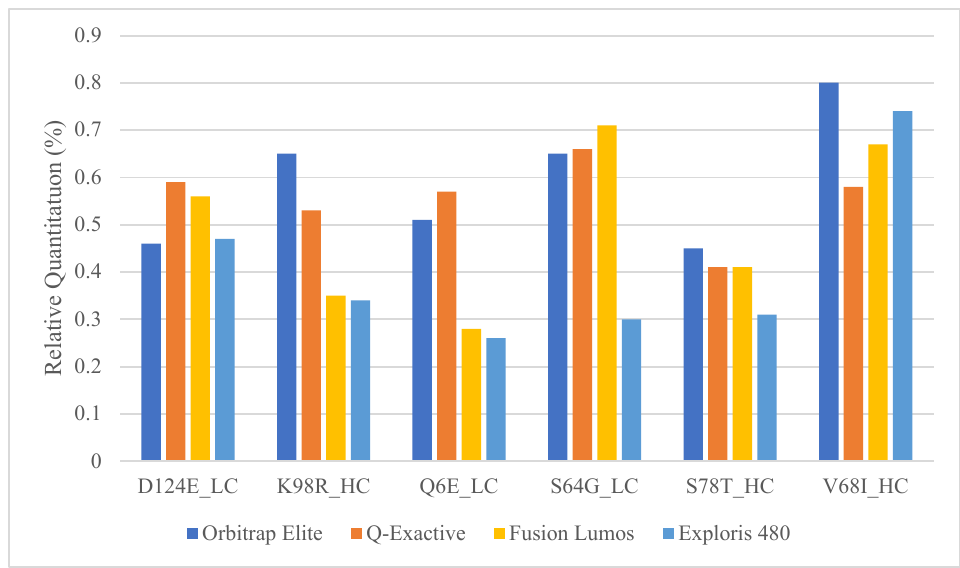
Figure 3. Relative quantitation of the mAb1 and mAb2 peptide pairs in commonly used Orbitrap platforms.